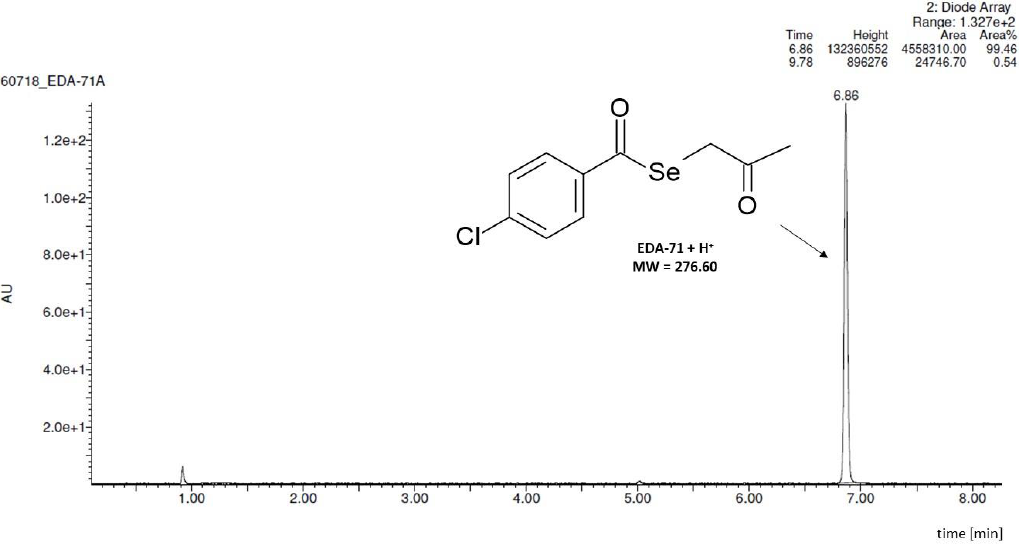
Figure 5. Stability of EDA-71 during its analysis in organic solvents. The assay confirmed the presence of only one peak, which corresponded to the weight of EDA-71 ( m / z = 276.60). Diode Array, range: 1.327× 10 2 .